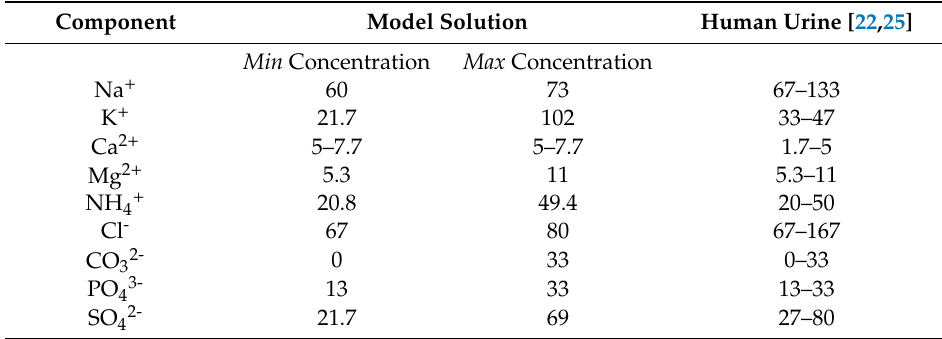
Table 1. Elemental composition (mmol / L) of model solutions and